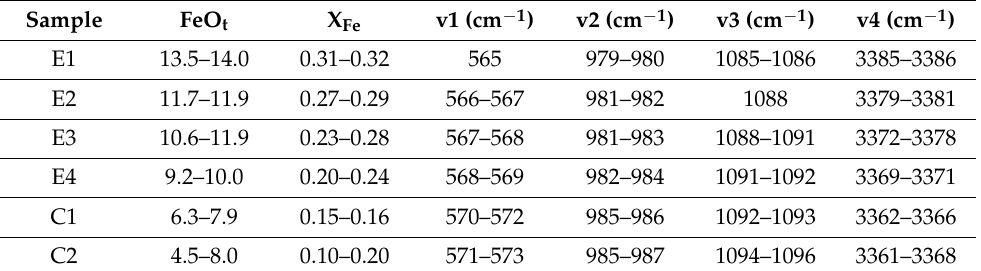
Table 1. Total iron content determined by SEM–EDS, X Fe values, and position of Raman peaks ν 1, ν 2, ν 3, and ν 4 for the six epidote and clinozoisite